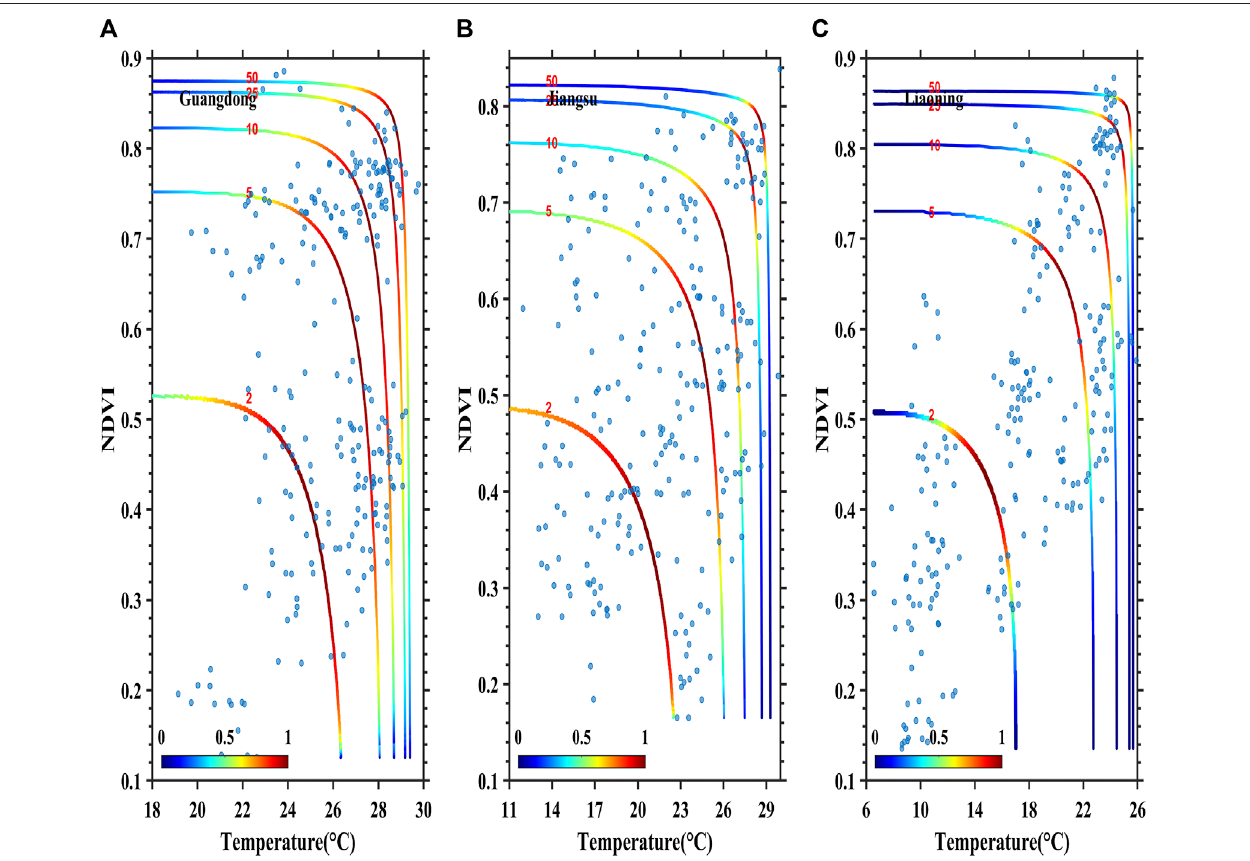
FIGURE 6 | Survival copula return periods of mean temperature-normalized difference vegetation index (NDVI) in (A) Guangdong, (B) Jiangsu, and (C) Liaoning.